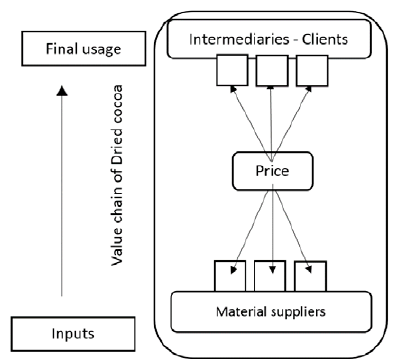
Figure 4. Coordination mechanism at CCN- 51 cacao